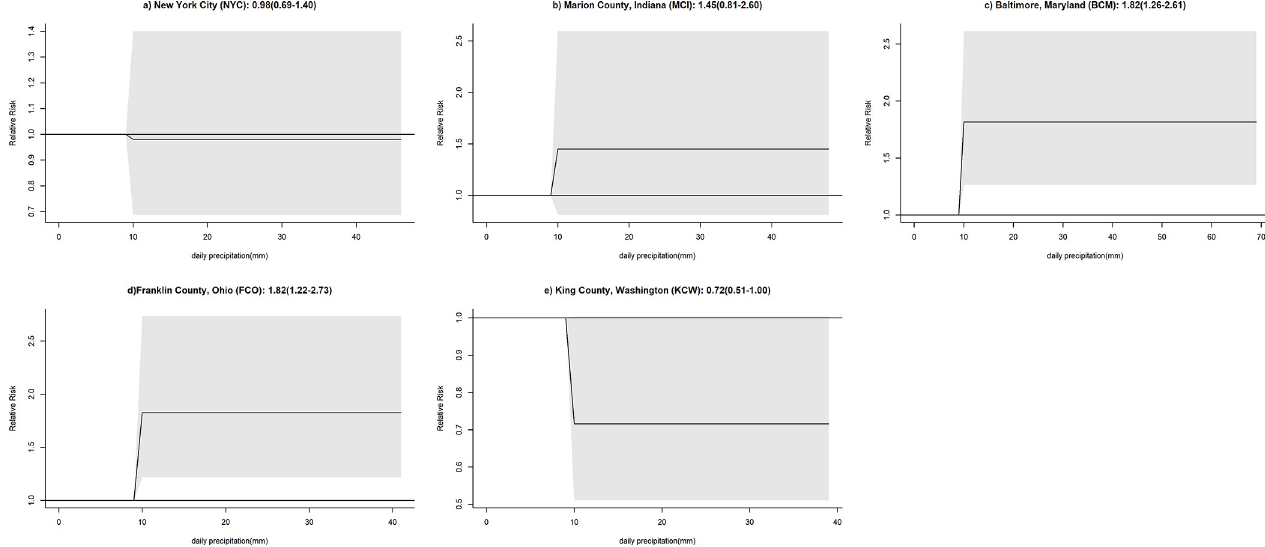
Fig 9. Effect of precipitation on COVID-19 infection risk with precipitation classified into two categories using a threshold of 10 mm. The model was adapted to estimate the risk of COVID-19 infection above 10 mm of precipitation relative to the risk of COVID-19 up to 10 mm of precipitation. Shaded areas represent 95% confidence